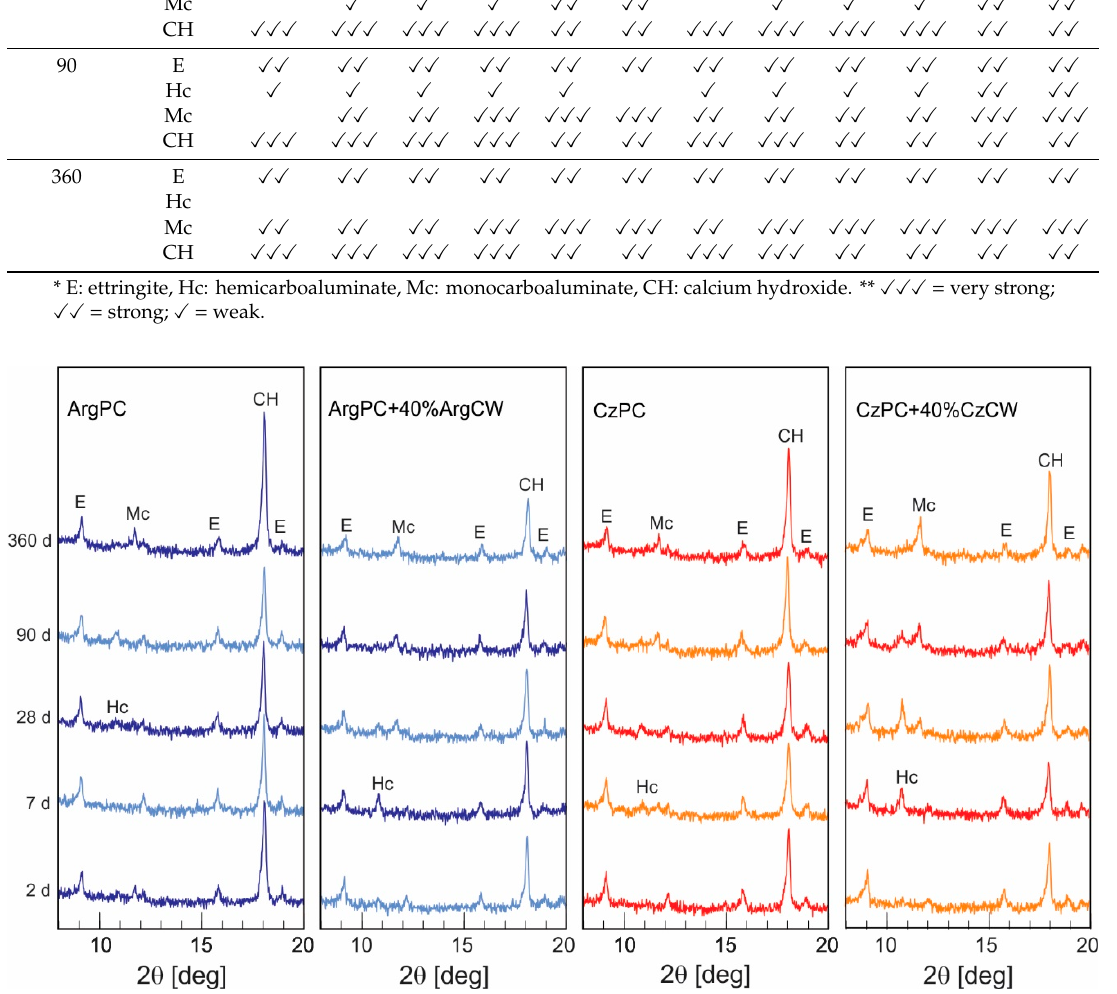
Figure 10. XRD pattern for ( a ) ArgPC; ( b ) ArgPC + 40%ArgCW; ( c ) CzPC; ( d ) CzPC + 40%CzCW. (E: